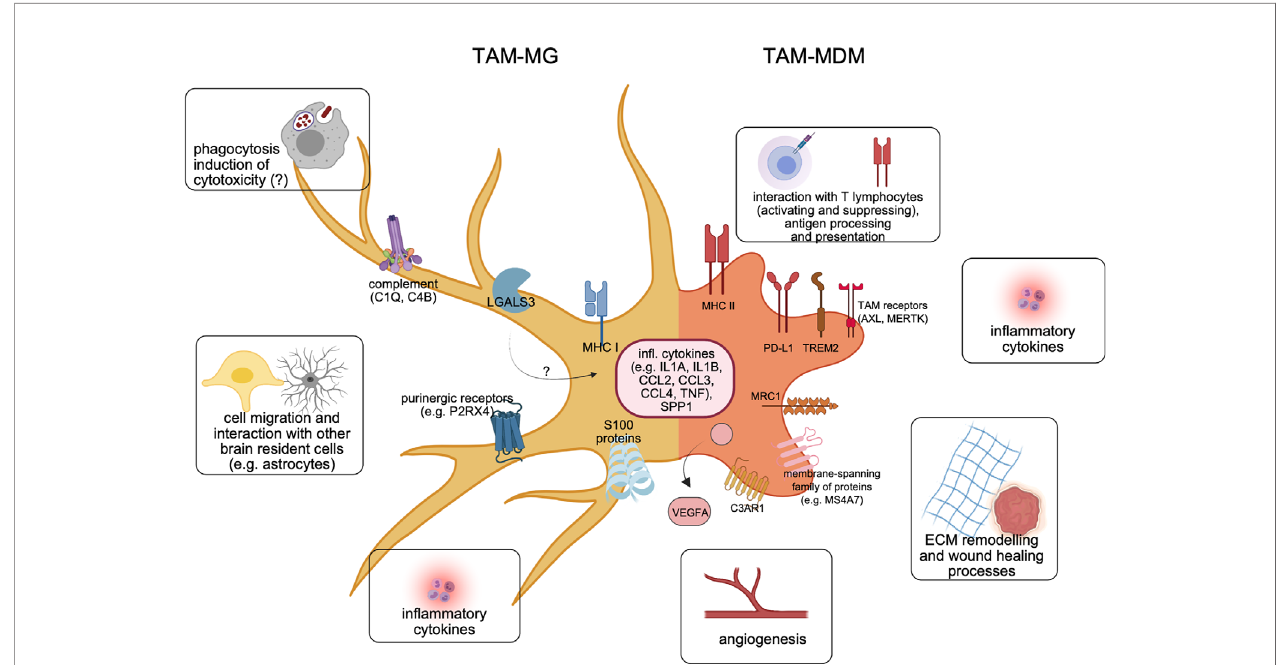
FIGURE 3 | Molecular features of both major TAM populations in BrM. Recent cellular and molecular fi ndings underline the differences of TAM-MG (left) vs . TAM- MDM (right) within the BrM microenvironment. Representative markers shared between TAMs from murine or human BrM are illustrated, together with major functional